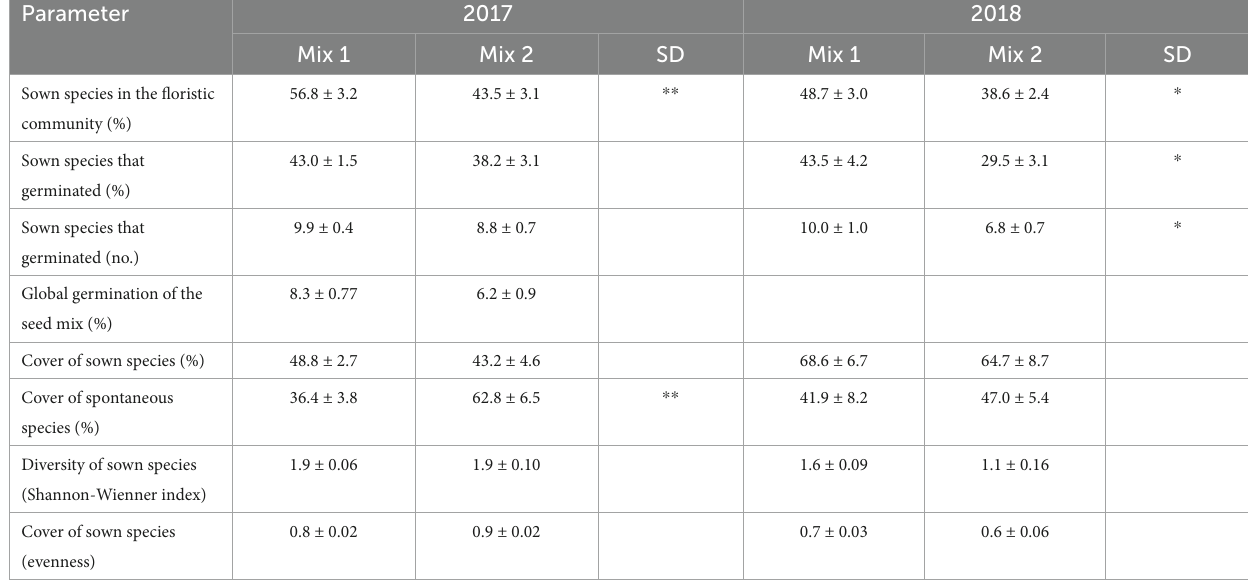
TABLE 1 Comparative analysis of the results obtained in 2017 and 2018 for different parameters of the floristic community (mean ± standard error) in the two mixes sowed in the ex-situ plots at Herdade da Mitra.